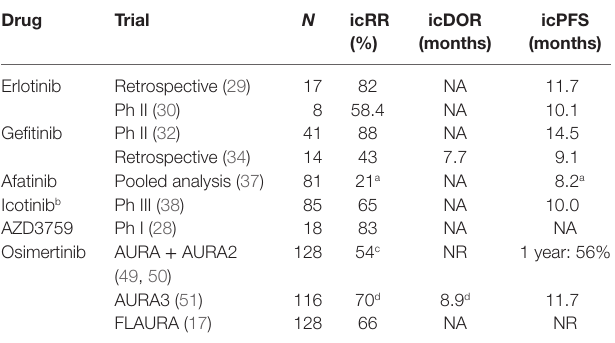
TABLe 1 | Efficacy of EGFR tyrosine kinase inhibitors (TKIs) in EGFR -mutant non-small cell lung cancer (NSCLC) patients and brain metastases (BM). Drug Trial N icRR